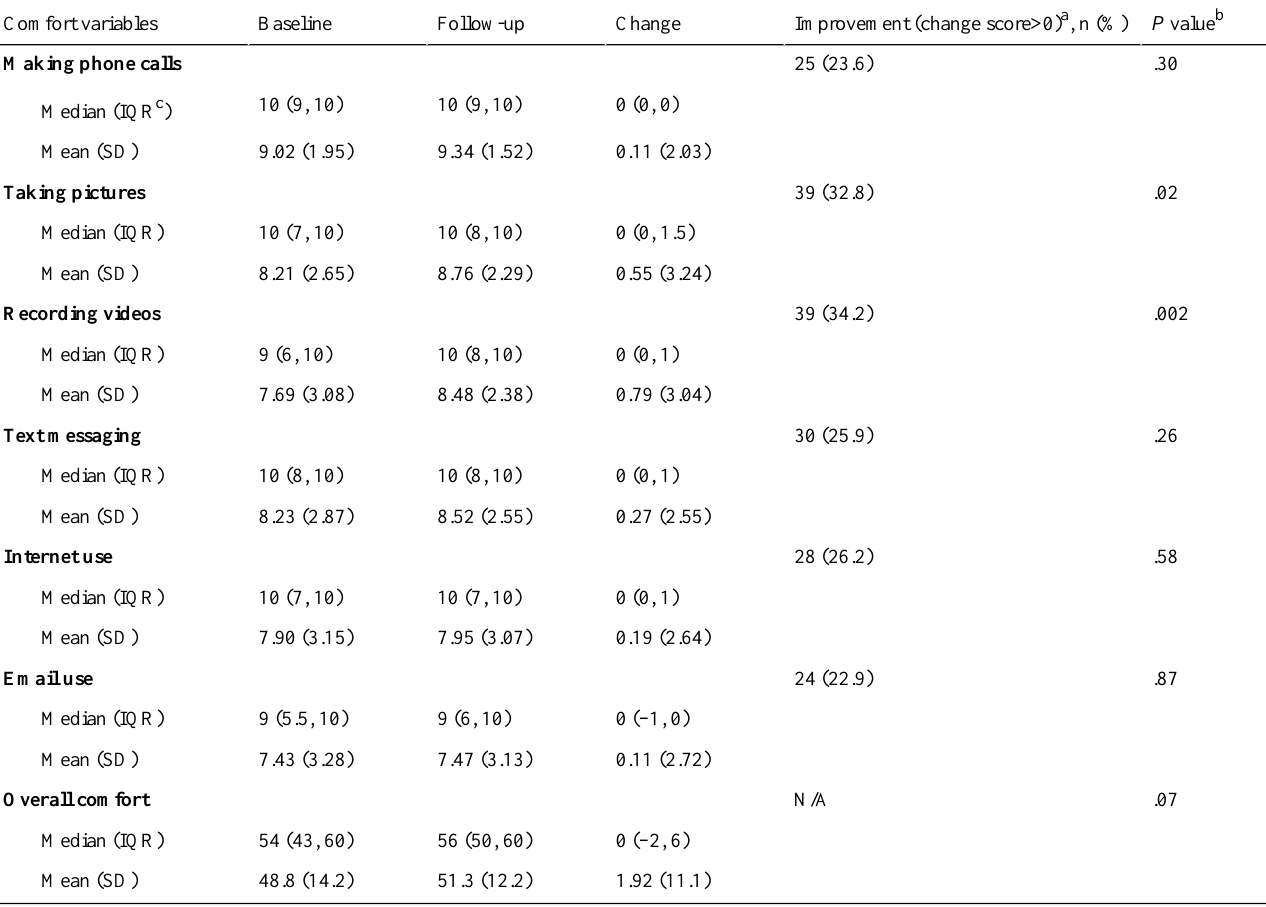
Table 1. Self-reported comfort score using mobile phone features before and after using an mHealth app to monitor antituberculosis treatment adherence among patients in San Diego, San Francisco, and New York City